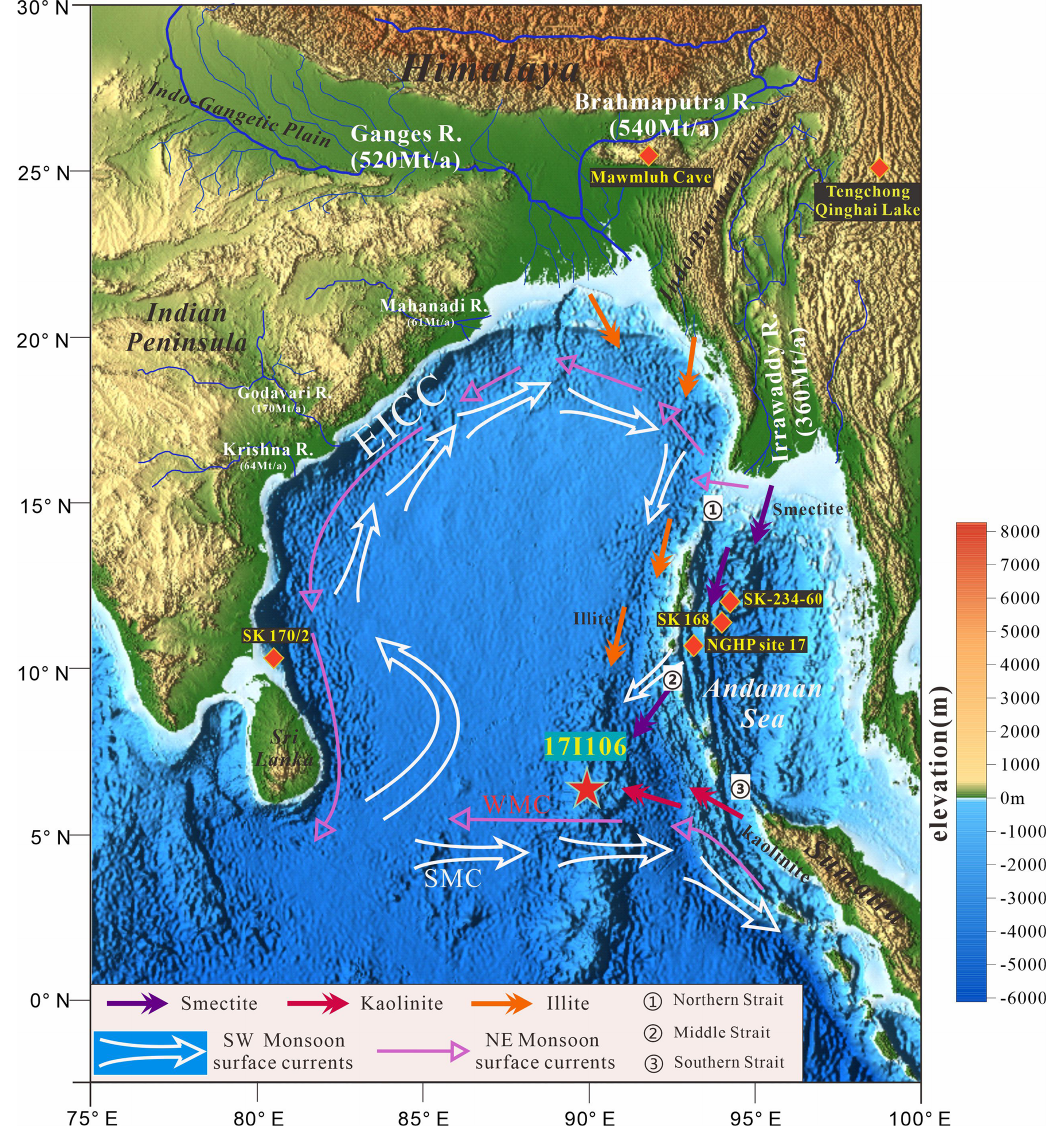
Figure 5. Map showing dispersal patterns of the BoB clay minerals for core 17I106. The locations of core 17I106 (red asterisks) and of the reference core and sites are shown: SK 170/2 in the northern BoB, SK-168, SK-234-60, NGHP Site 17 in the western Andaman Sea, Mawmluh Cave in northeastern India, and Tengchong Qinghai Lake in China are represented by orange diamonds. The orange, purple, and red arrows represent the main dispersal directions of illite, smectite, and kaolinite when the fluvial sediments were discharged into core 17I106. The white and red arrows denote the SW and NE monsoon currents, respectively. In the western BoB, the East Indian Coastal Current (EICC) reverses annually with the monsoon wind (Schott and McCreary, 2001). In the lower-latitude regions of the BoB, monsoon-driven currents flow eastward in summer to form the summer monsoon current (SMC) and westward in winter to form the winter monsoon current (WMC) (Shankar et al., 2002). The elevation legend is shown to the right of this